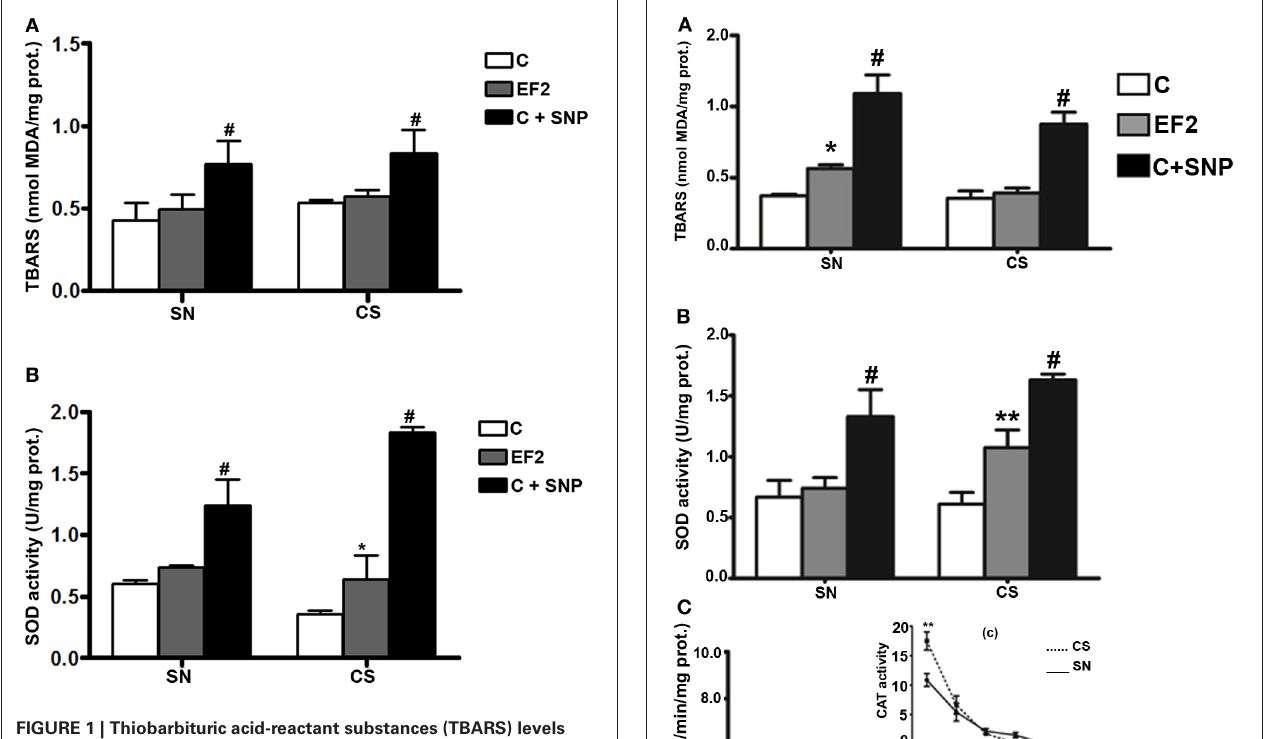
FIGURE 1 | Thiobarbituric acid-reactant substances (TBARS) levels (A) and total superoxide dismutase (t-SOD) activities (B) in the pool of Substantia Nigra and Corpus Striatum from first generation adult rats fed essential fatty acid restricted diet and controls ( n = 12 per group). ∗ P < 0 . 05 compared to control group. Treatment of control homogenates with sodium nitroprusside (SNP) was used as positive control in all the experiments. # P < 0 . 001 compared to control or EF1 groups.